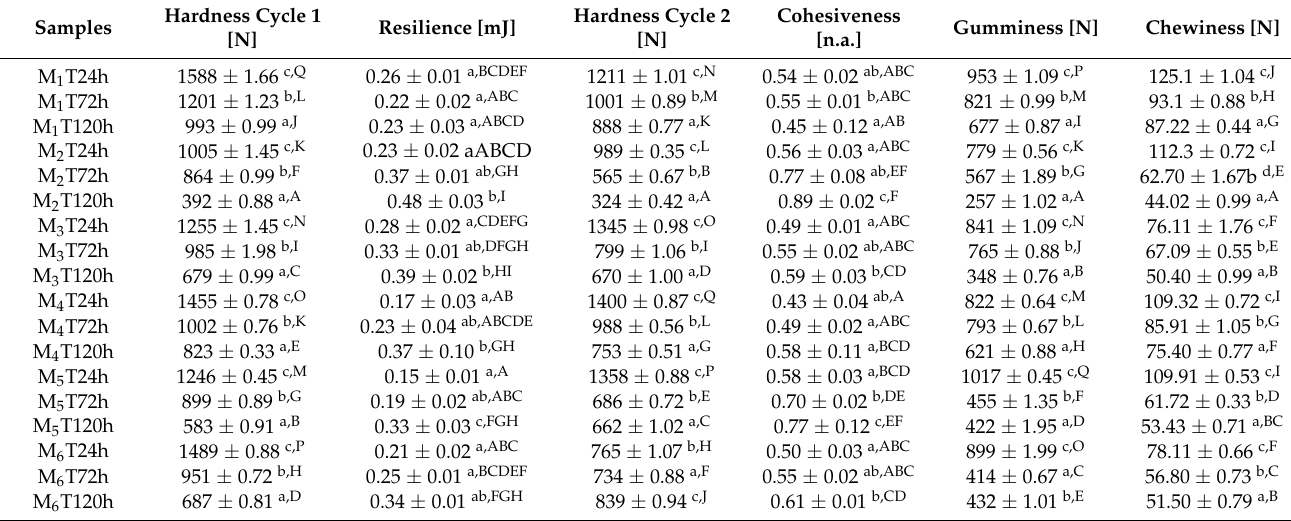
Table 10. Texture profile analysis of cooked meat